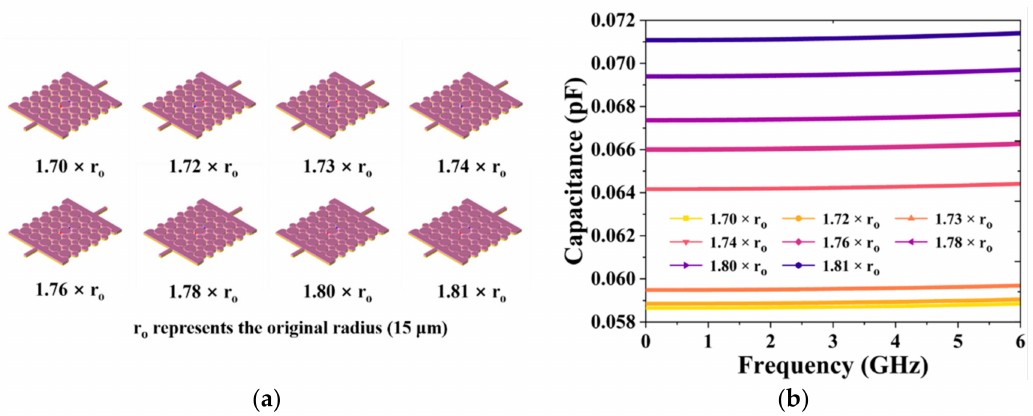
Figure 5. ( a ) Three-dimensional structure of the proposed capacitor with 1.70-, 1.72-, 1.73-, 1.74-, 1.76-, 1.78-, 1.80-, and 1.81-radius GSMS, as well as their corresponding ( b ) capacitance performances.